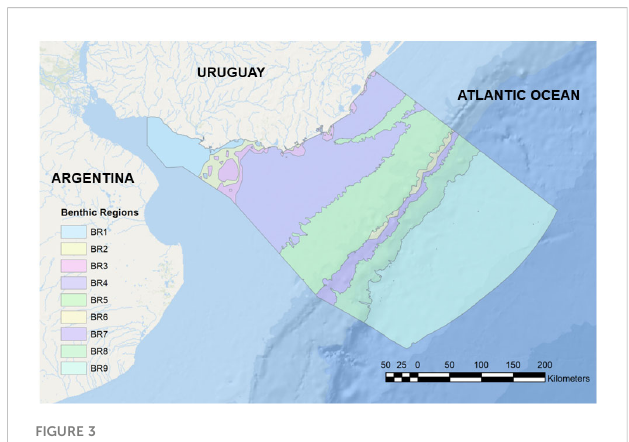
FIGURE 3 Benthic Regions (BRs) for the Uruguayan EEZ, with outlined boundaries. BRs are numbered and named in Table